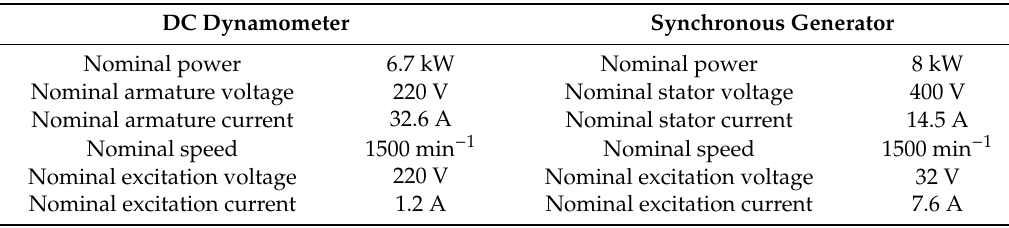
Table A2. DC dynamometer and synchronous generator nameplate